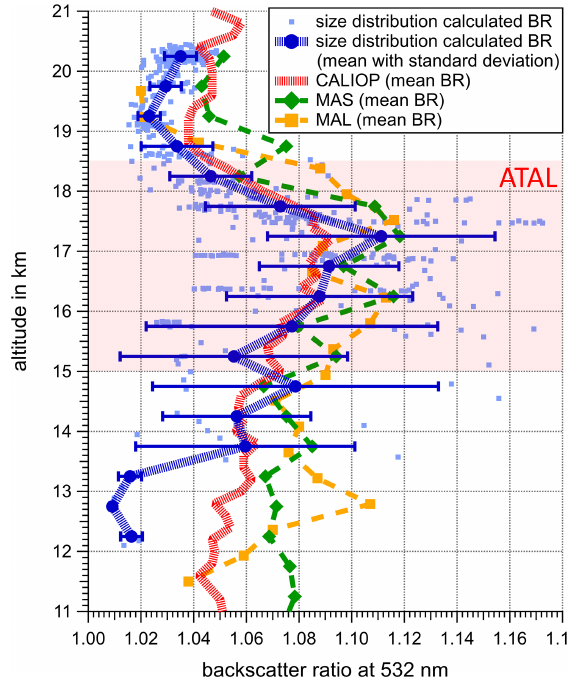
Figure 7. Vertical profile of the backscatter ratio at a 532nm wave- length, calculated based on the aerosol size distributions measured during the 2017 StratoClim measurement campaign (blue dots, 100s averages), showing the mean profile (blue line) and the stan- dard deviation (blue bars). The mean profiles of the backscatter ratio at a 532nm wavelength measured by CALIOP, MAS, and MAL are plotted in red, green, and orange,